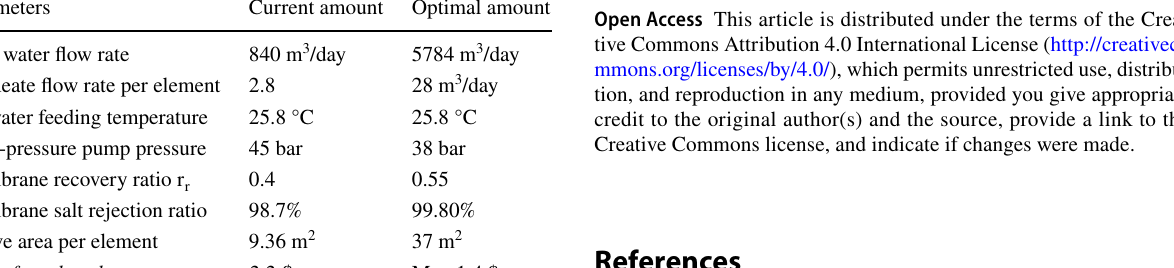
Table 3 Initial and optimal working parameters of CMU desalination plant